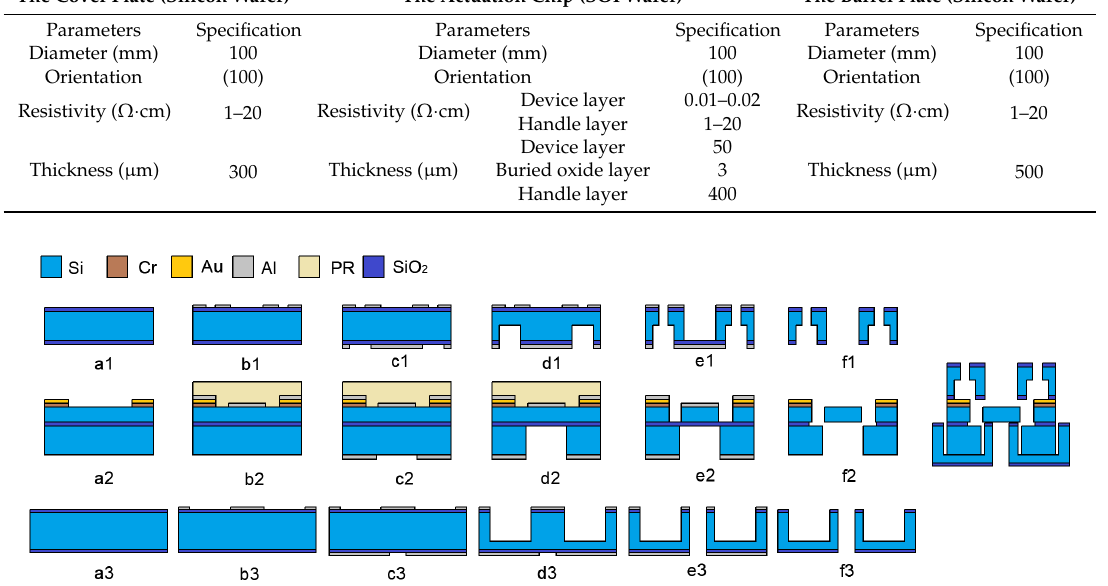
Figure 9. The fabrication processes. ( a1 ) Insulation layer. ( b1 ) Front mask layer. ( c1 ) Backside